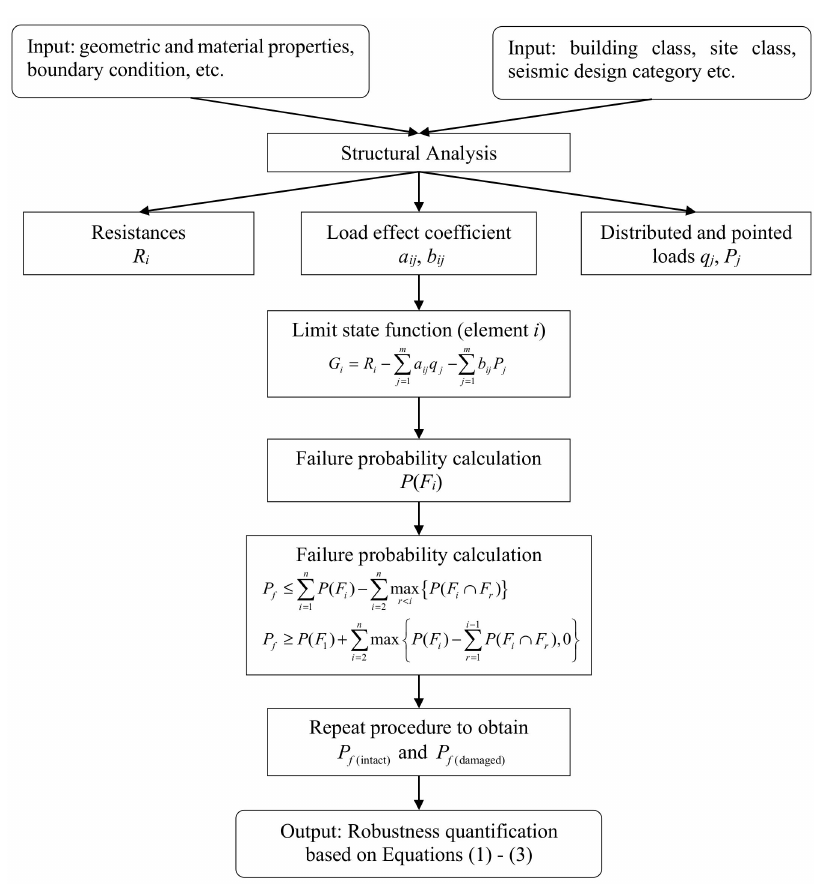
Figure 2. Calculation procedures within the robustness quantification